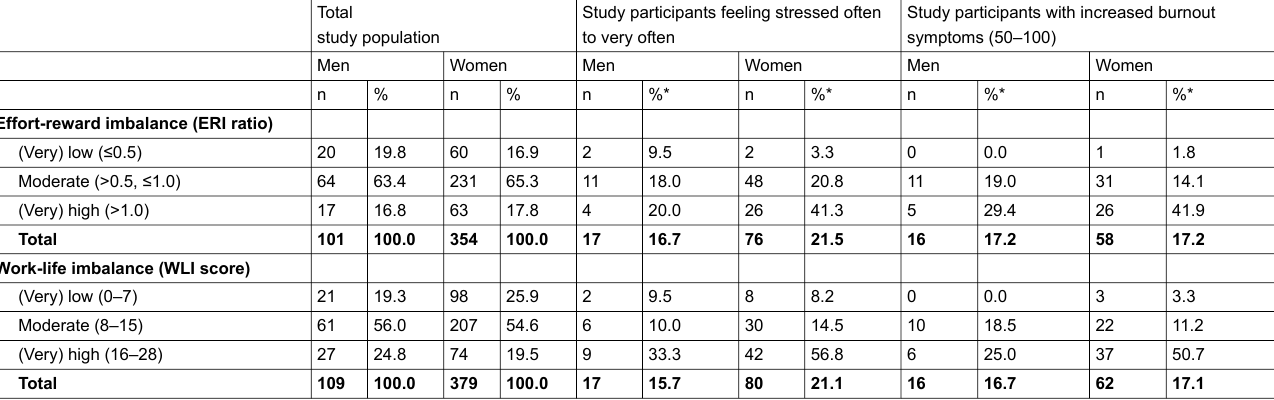
Table 2: Gender-specific numbers of cases and prevalence rates of (very) frequent stress feelings and increased burnout symptoms by degree of effort-reward and work- life